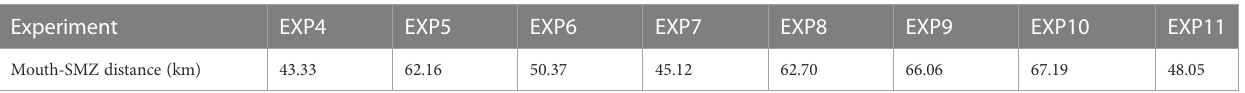
TABLE 4 The distances of the salt plug centers (where ∂ s ∂ x ¼ 0 ) from the estuary mouth in the 8 numerical experiments of EXP4-EXP11 (These distances are considered as L r to compute the tidal Froude